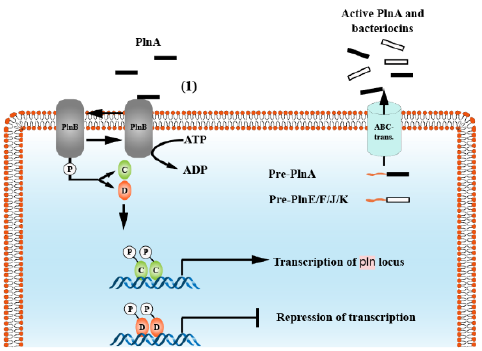
Figure 3. A schematic diagram of the biosynthesis of plantaricinE/F and